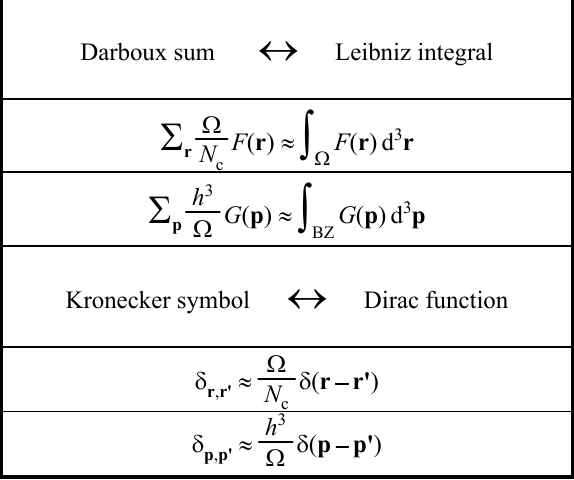
Fig. 3 . Cellular functions w complementary to the discrete n,m plane waves, in two dimensions x and y . Two functions are shown in the figure, namely w and w − , centred at { x = 5,2 3, − 6 n = 2 a } and { x = − 3 a , y = − 6 a } respectively. The 5 a , y m n m cellular functions make up an orthonormal basis set of the Hilbert space. In the continuum limit a → 0, the cellular function w tends to δ ( x − x ) δ ( y − y ). n,m n m